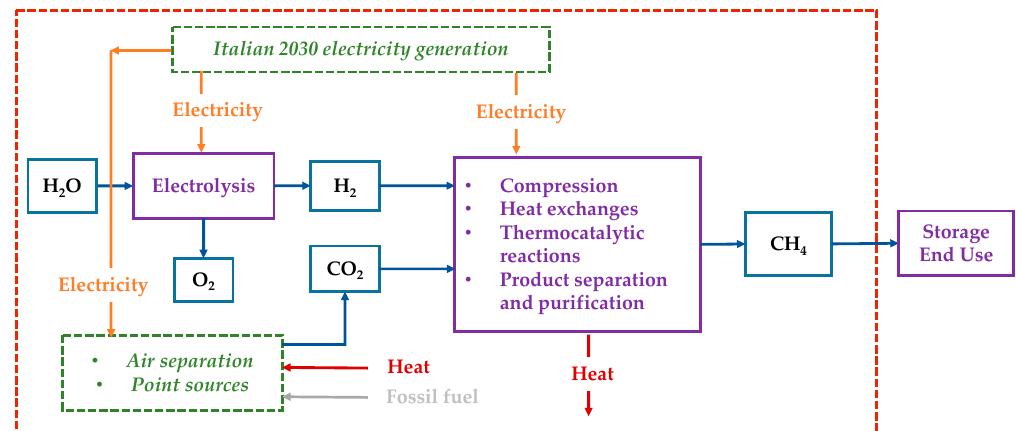
Figure 2. Study boundaries .